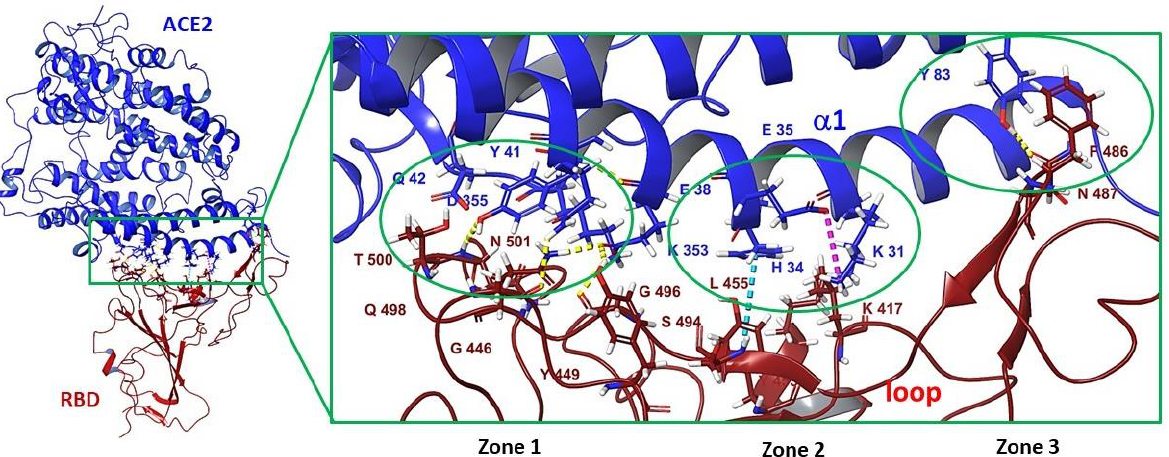
Figure 11. Interface of the receptor-binding S-protein of SARS-CoV-2 coronavirus with ACE2: hy- drogen bonds, salt bridges, and pi – pi stacking interactions are shown in yellow, purple, and blue drogen bonds, salt bridges, and pi–pi stacking interactions are shown in yellow, purple, and blue intermittent lines, respectively. intermittent lines,